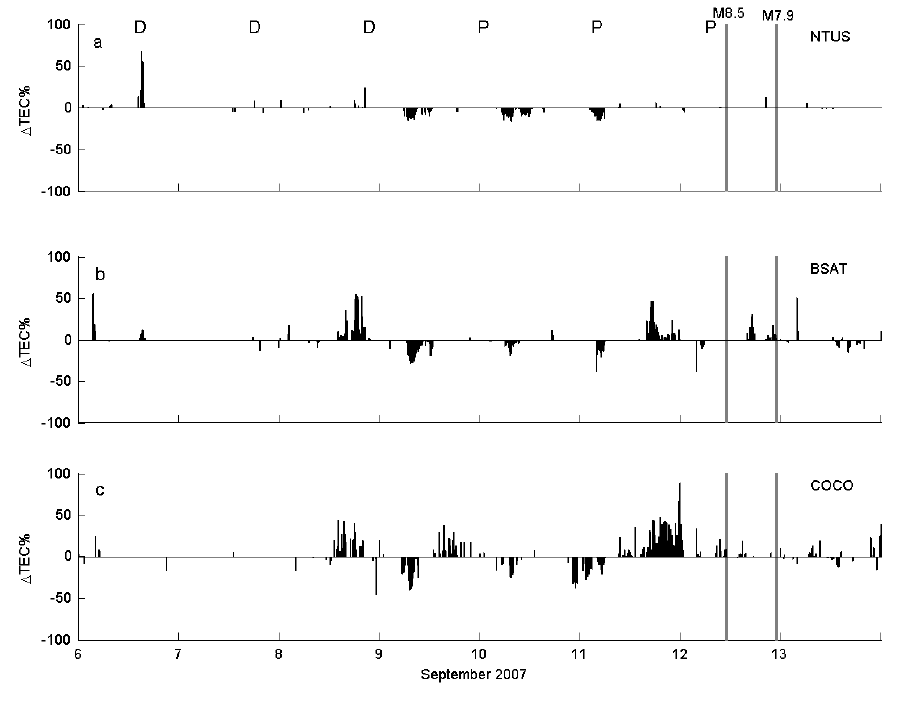
Fig. 10. The percentage of TEC deviation between 6 and 13 September 2007 at 3 GPS stations.